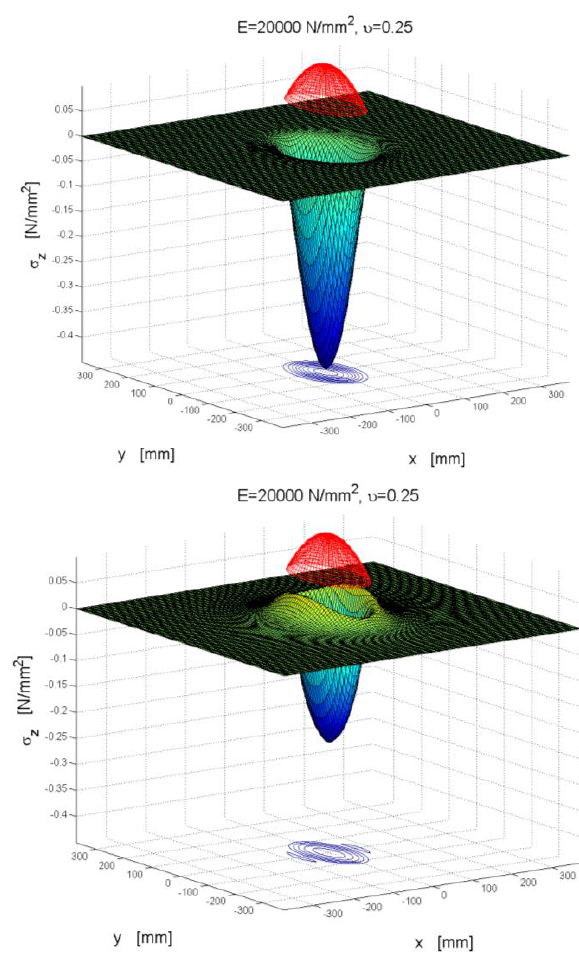
Figure 26: 3-D surfaces and stress contours of σ z near the surface: Boussinesq’s solution on the left and the second order solution on the